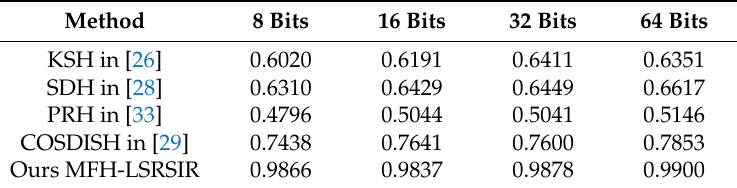
Table 5. Comparison MAP scores for different methods with varied hash bits in the SAT-6 dataset.